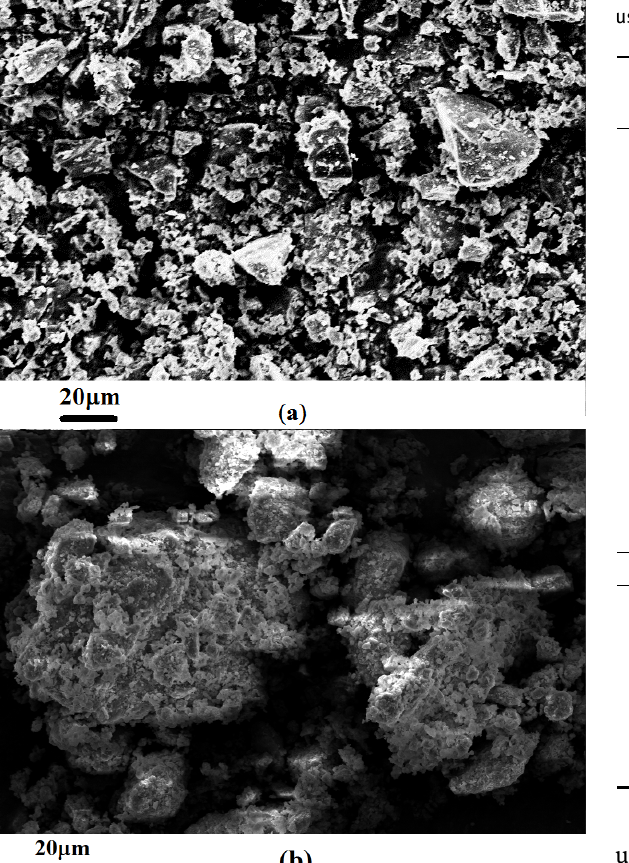
Table 1: Chemical analysis and physical properties of cement and LF